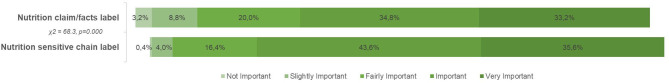
Comparison of the perceived importance of existing nutrition labels and a proposed chain-based label on dairy products.